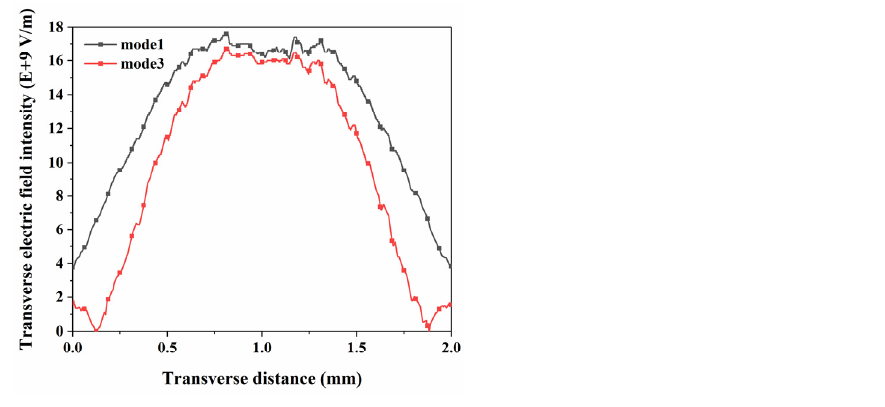
Figure 6. Transverse electric field distribution of fundamental mode and higher-order mode.